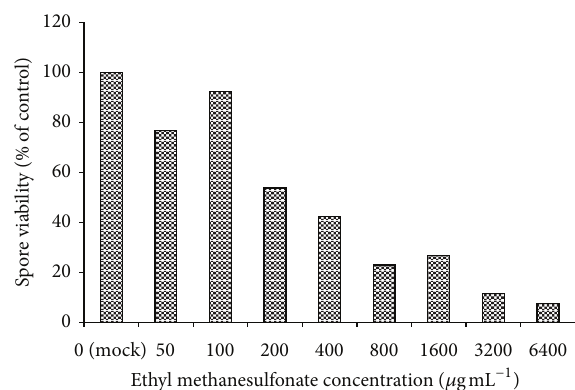
Figure 1: Ethyl methanesulfonate mutagenesis of Aspergillus oryzae . Aspergillus oryzae spore viability was reduced in a dose-dependent manner by ethyl methanesulfonate (EMS) treatment. Spore treat- ment with 1600 𝜇 g mL −1 EMS was used to generate the A. oryzae mutants screened for secretion of antibacterial